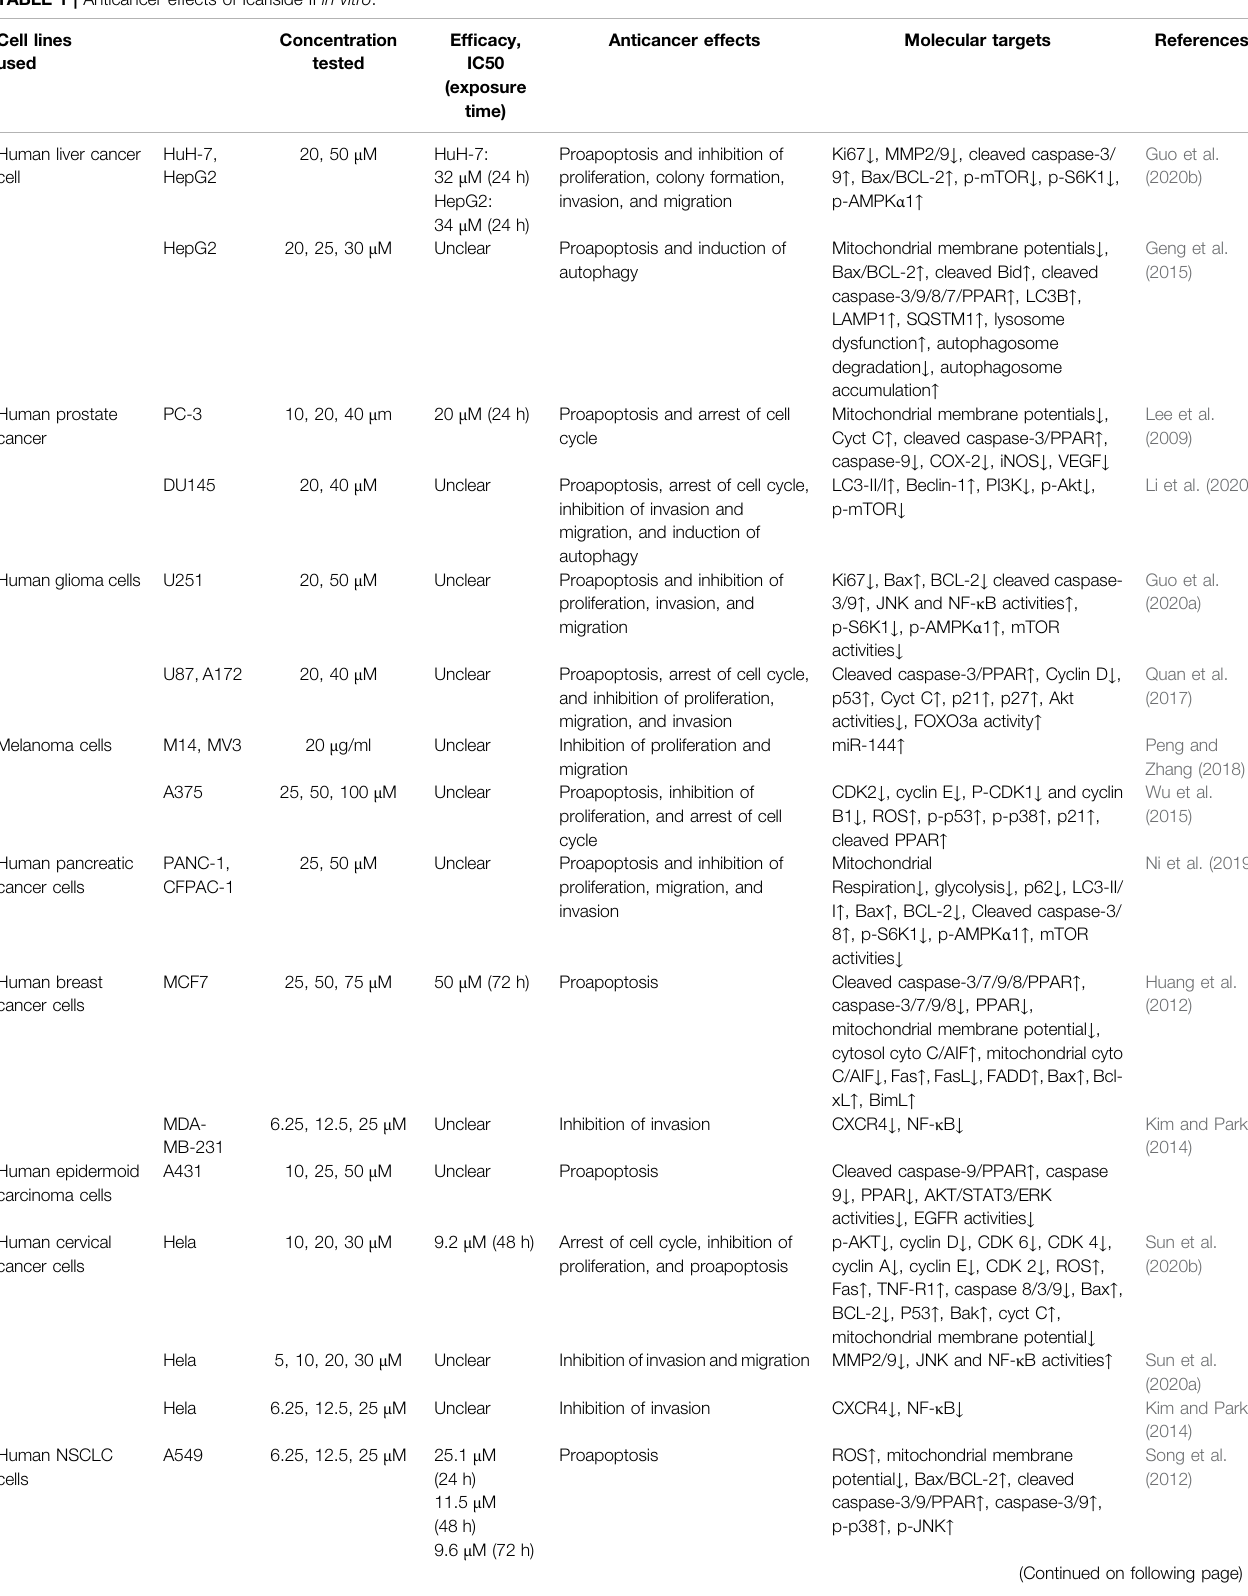
TABLE 1 | Anticancer effects of Icariside II in vitro